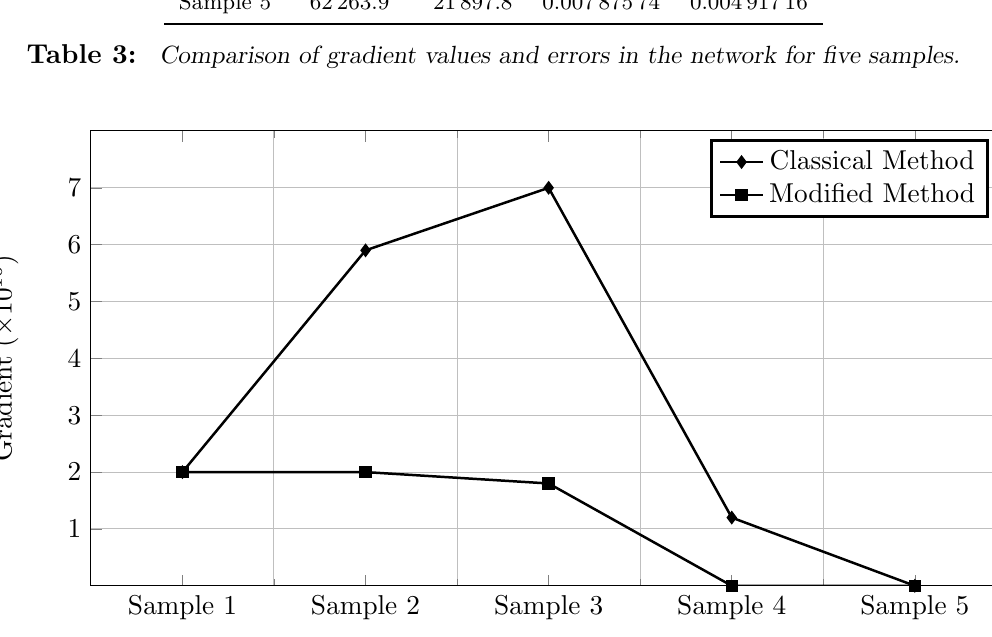
Figure 3: Comparison of descent gradient and proposed conjugate descent